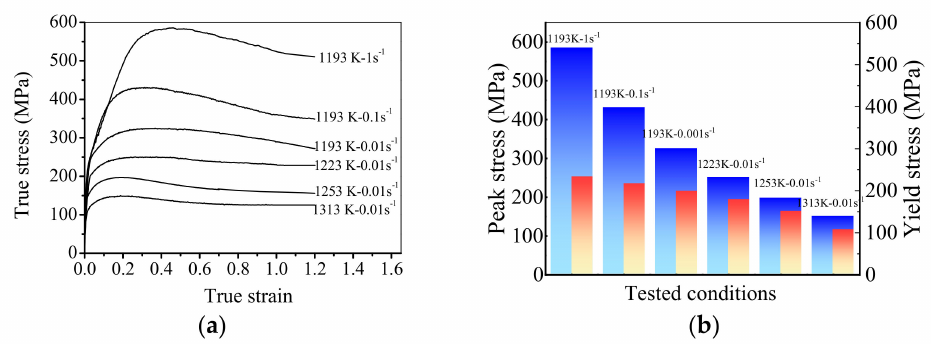
Figure 2. Flow stress of the studied superalloy during hot compression: ( a ) True stress-true strain curves; ( b ) variations of peak stress and yield stress under the tested conditions.